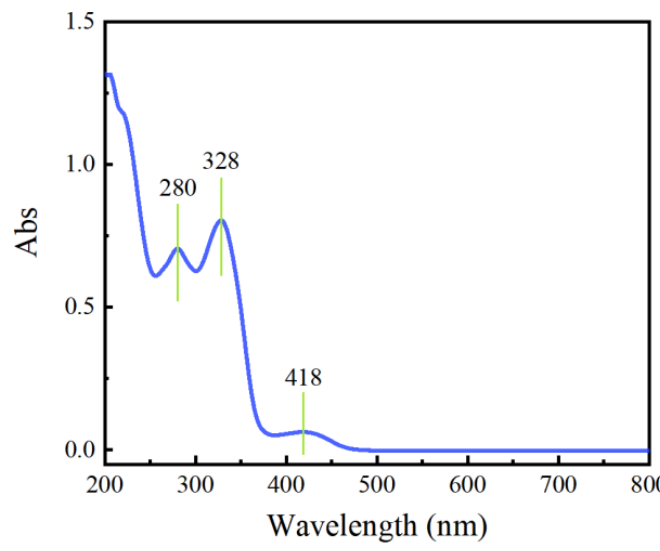
Figure 2. Absorption spectrum of P. amurense dye solution.